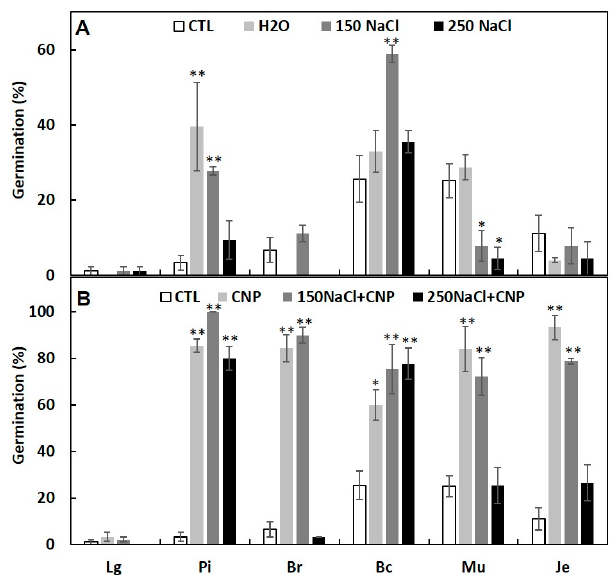
Figure 4. ( A ) Germination of lettuce seeds pretreated with H 2 O, 150 mM NaCl, 250 mM NaCl for 4 h prior to an imbibition in 150 mM NaCl solution for nine days; ( B ) Germination of lettuce seeds pretreated with CNP, 150 mM NaCl + CNP, 250 mM NaCl + CNP for 4 h prior to an imbibition in 150 mM NaCl solution for nine days. CTL: seeds without any pretreatment. * and ** denote the statistical significance compared to CTL at the p < 0.05 and p < 0.01 level,